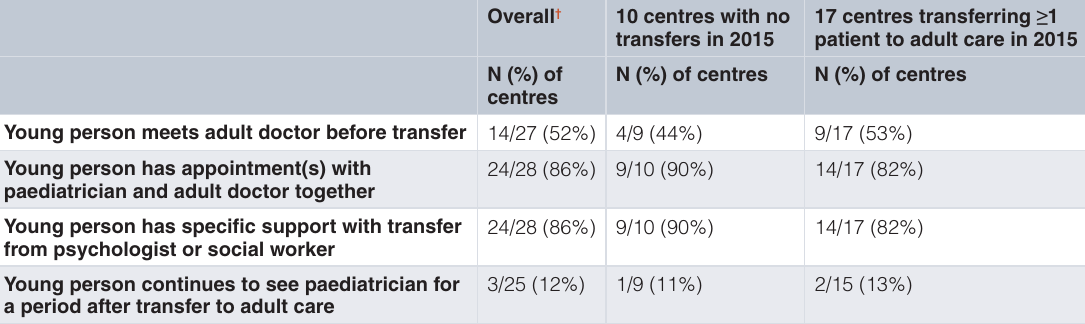
Table 2. Number and proportion of regional/municipal HIV/AIDS centres offering different types of transition support.